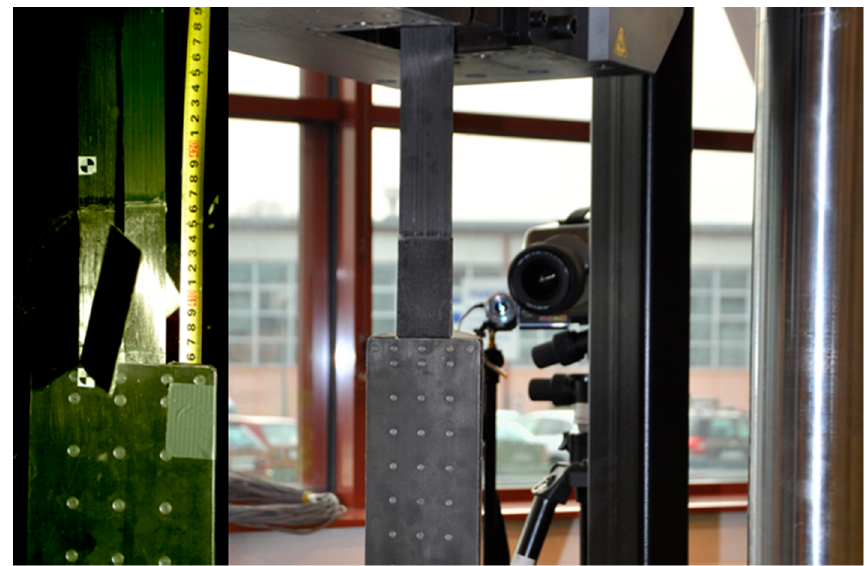
Figure 11. Recording the failure mode using the speed video camera with a high framing rate and an example of the view.